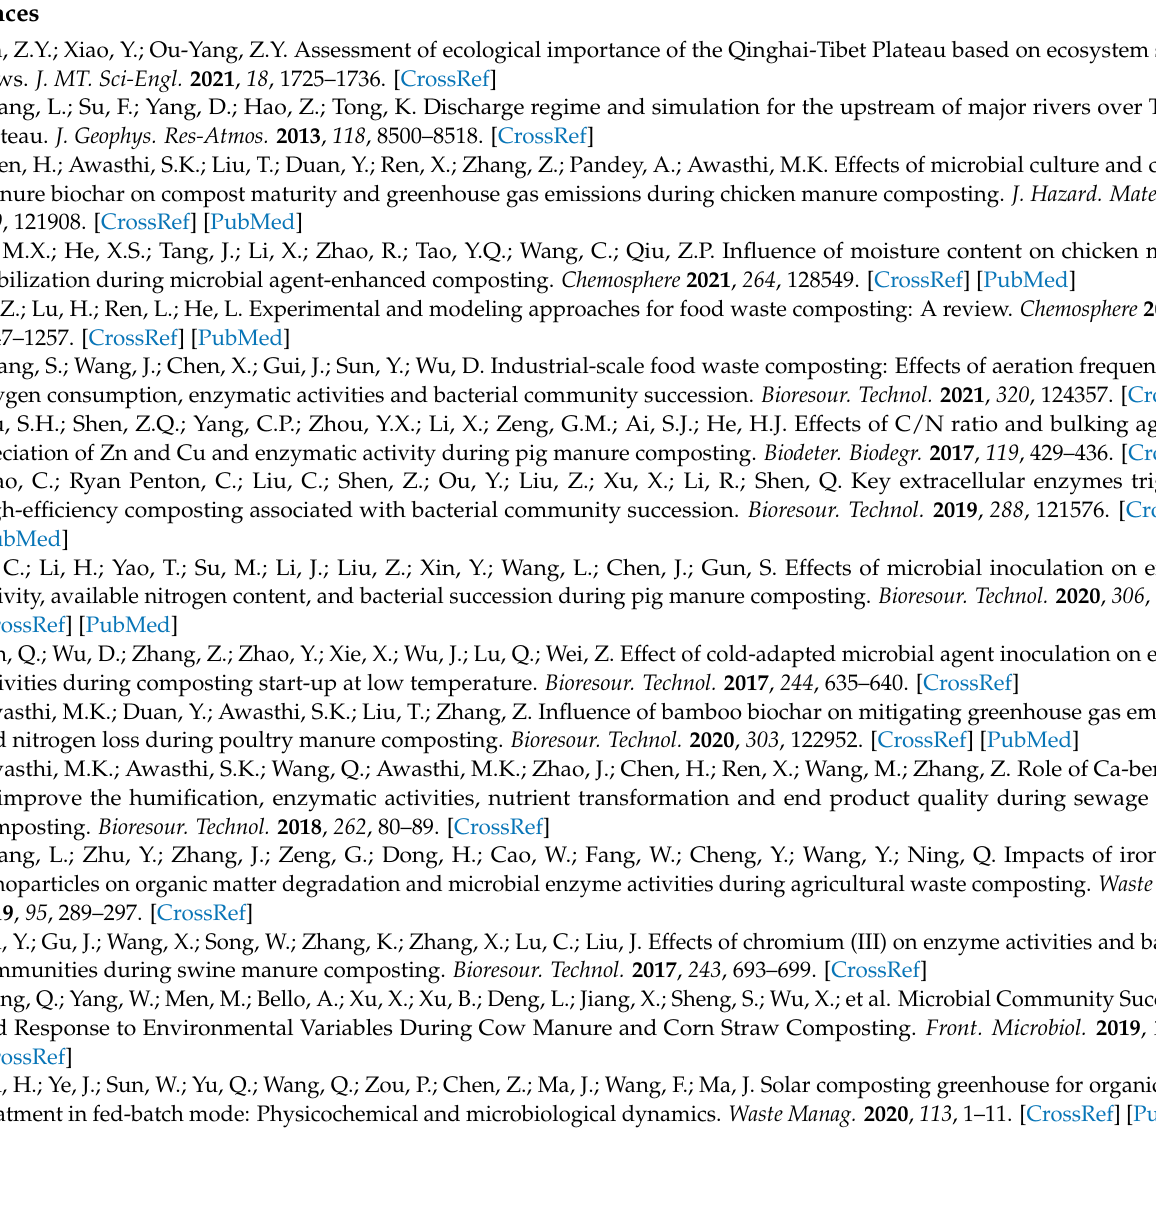
Table S1: Changes in physicochemcal indicators; Table S2: Fungal top 37 metabolic pathways and their corresponding